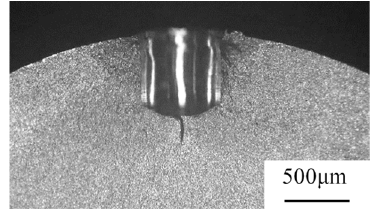
Figure 5. Typical fatigue crack initiation from an artificial defect ( √ area ≈ 0.6 mm).